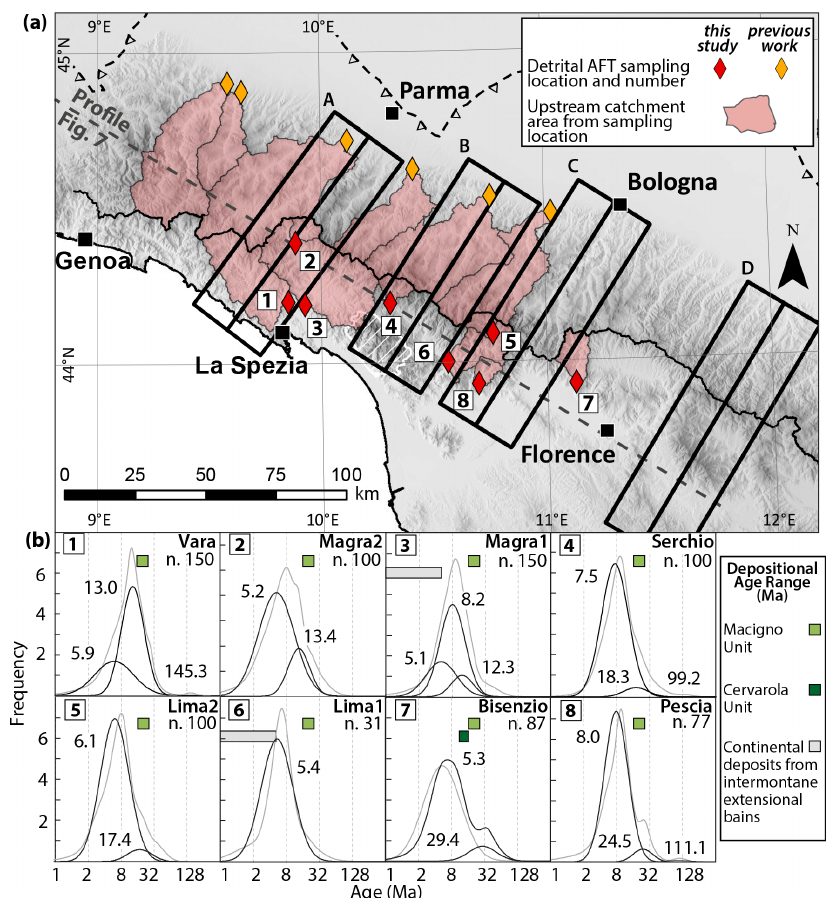
Figure 3. (a) Location map for detrital samples. Detrital AFT samples from this study are illustrated as red diamonds, and published detrital AFT samples (Malusà and Balestrieri, 2012) are shown as yellow diamonds. Numbers in the white squares correspond to the age population plots shown in panel (b) . (c) Peak distribution curves (black curves), total probability density functions (PDFs) (grey curves), and peak ages (Ma) for all sampled Ligurian catchments. Catchment name and sample number (where applicable), and number of dated grains (n.) are given in the top right corner of each figure panel. Coloured rectangles in each plot give the range of stratigraphic ages for the youngest exposed Cenozoic foredeep units (Fig. 1) in the respective upstream catchment area. We also indicate the age range of the Pliocene–Pleistocene continental deposits, as these are potential sources of detrital apatite recycled from the Cenozoic foredeep units or from the Apuan Alps metamorphic rocks.